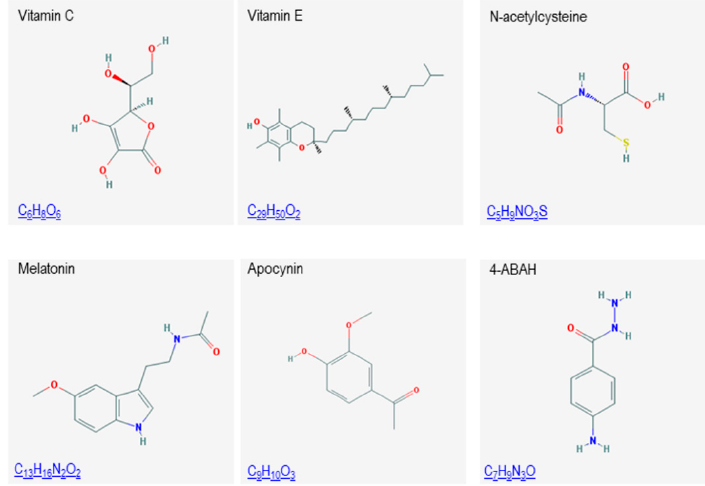
Figure 3. Chemical structures of different antioxidant compounds.